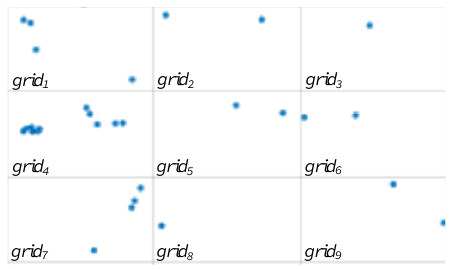
Figure 3. Distribution of intersection on grid